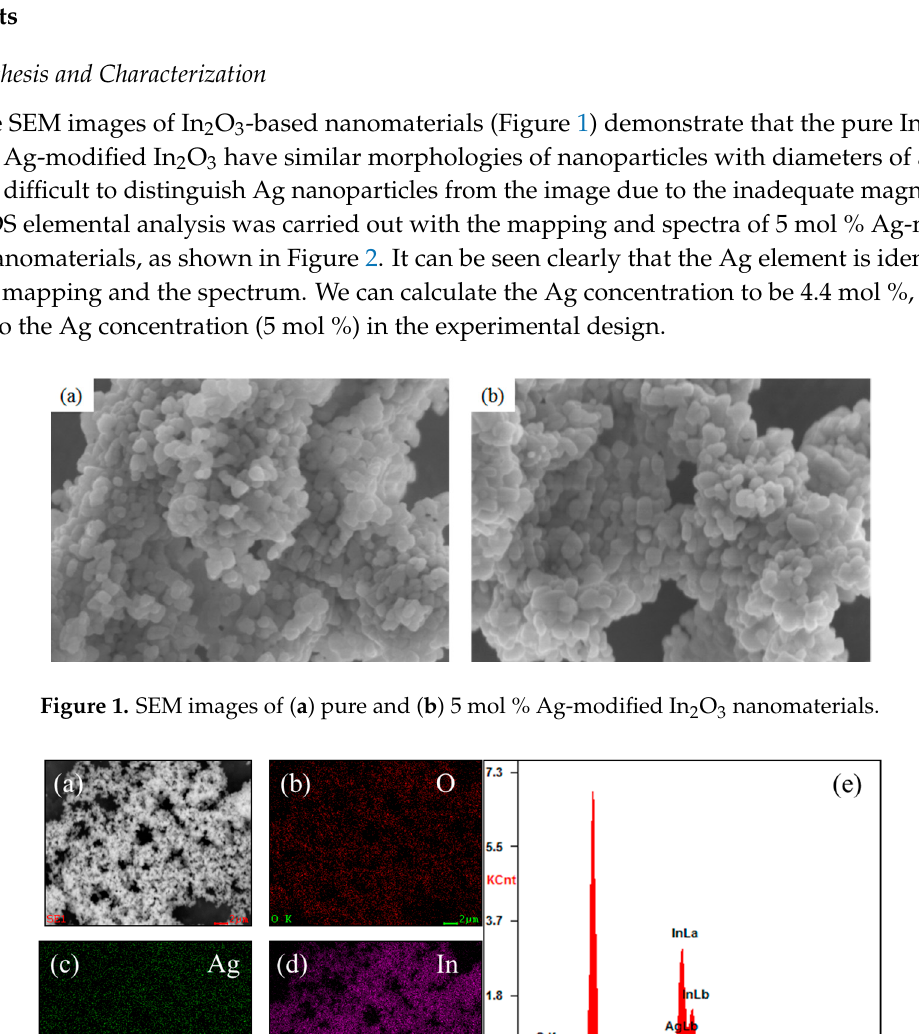
Figure 2. SEM images, element mapping and EDS spectrum of 5 mol % Ag-modified In 2 O 3 nanomaterials. ( a ) SEM image; ( b ) O; ( c ) Ag; ( d ) In mapping; and ( e ) EDS spectrum.